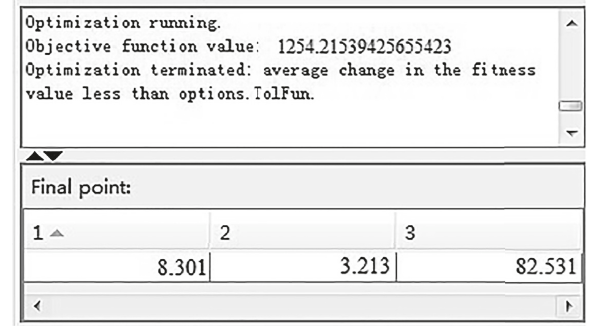
Figure 5: Optimization results of capacity.